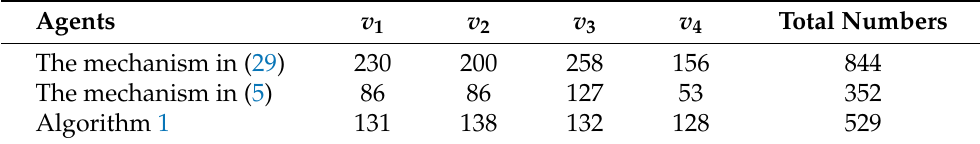
Table 1. The event numbers under the triggering mechanisms (29), (5), and Algorithm 1.